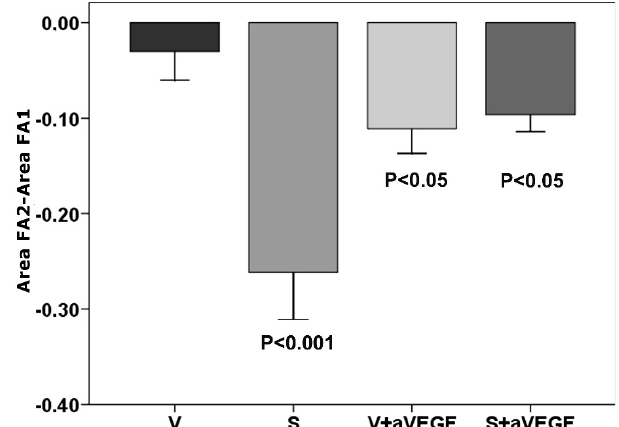
Figure 2. Fluorescein leakage. A decrease in active vessel area compared to the vehicle group (V) was apparent in all treated groups (nutritional supplement (S), supplement and anti-vascular endothelial growth factor agent (S + aVEGF), and vehicle and anti-VEGF agent (V + aVEGF)). There were 15 animals in each group and data are expressed as mean ± standard error of the mean.